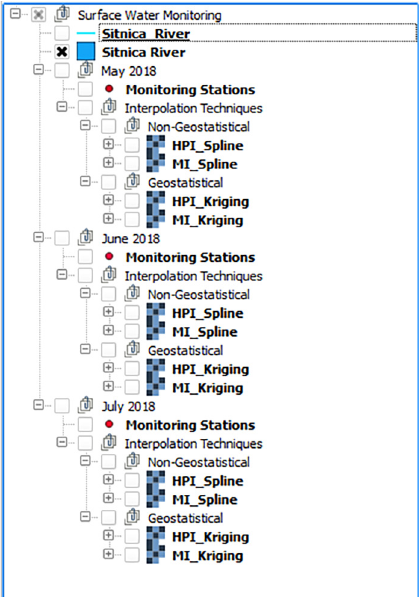
Figure 3. Data structure and thematic